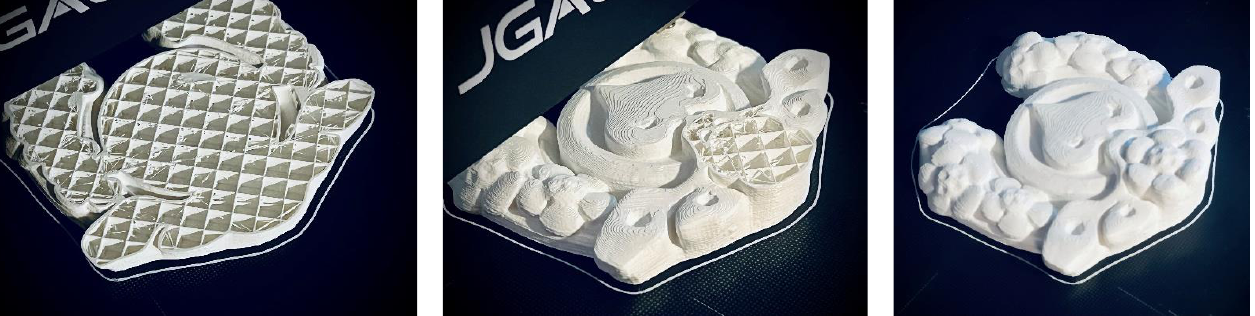
Figure 17. The process of 3D printing and the final result of one of the ornaments from the Lajos (Ludwig) Besch and Károly (Karl) Piffl Palace.